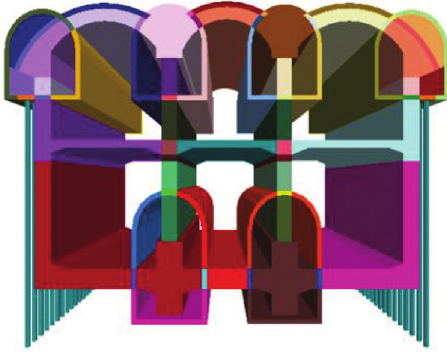
Figure 8: Support structure model of the